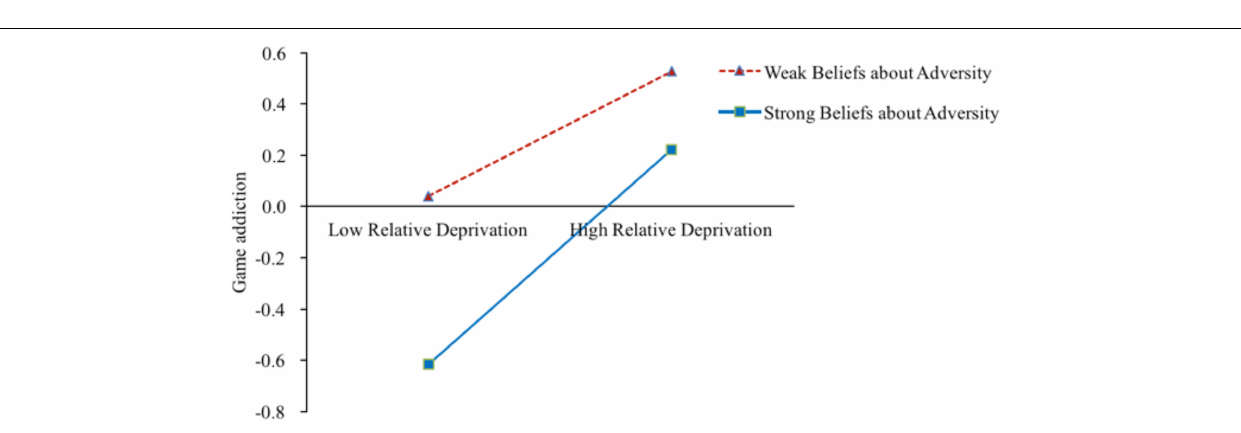
FIGURE 5 | Conditional effect of left-behind children’s game addiction as a function of relative deprivation and beliefs about adversity. M ± 1 SD of beliefs about adversity. N = 952.